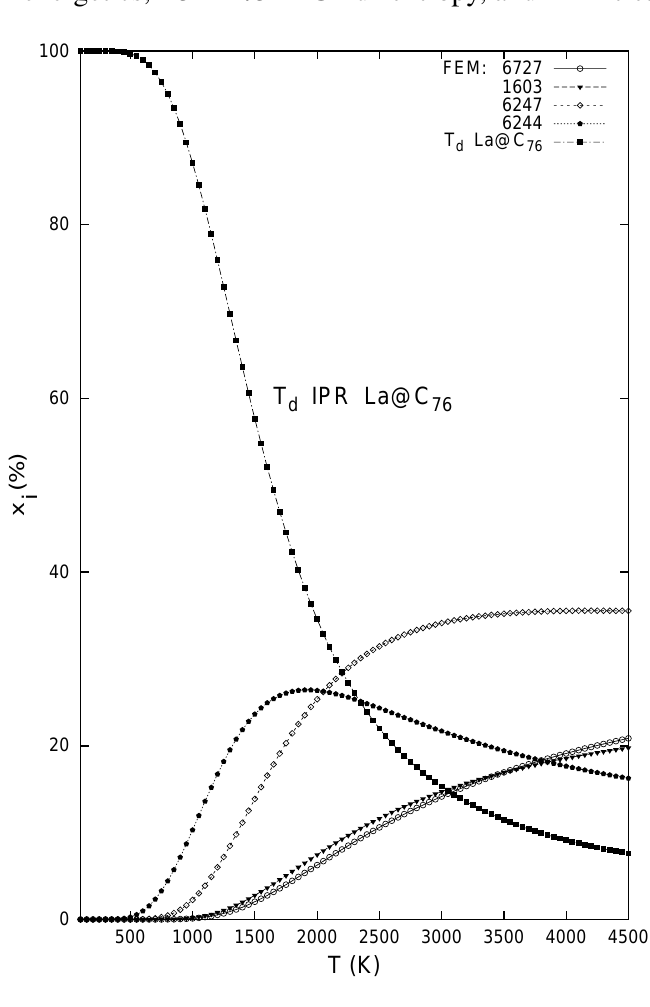
Relative concentrations of the La@C